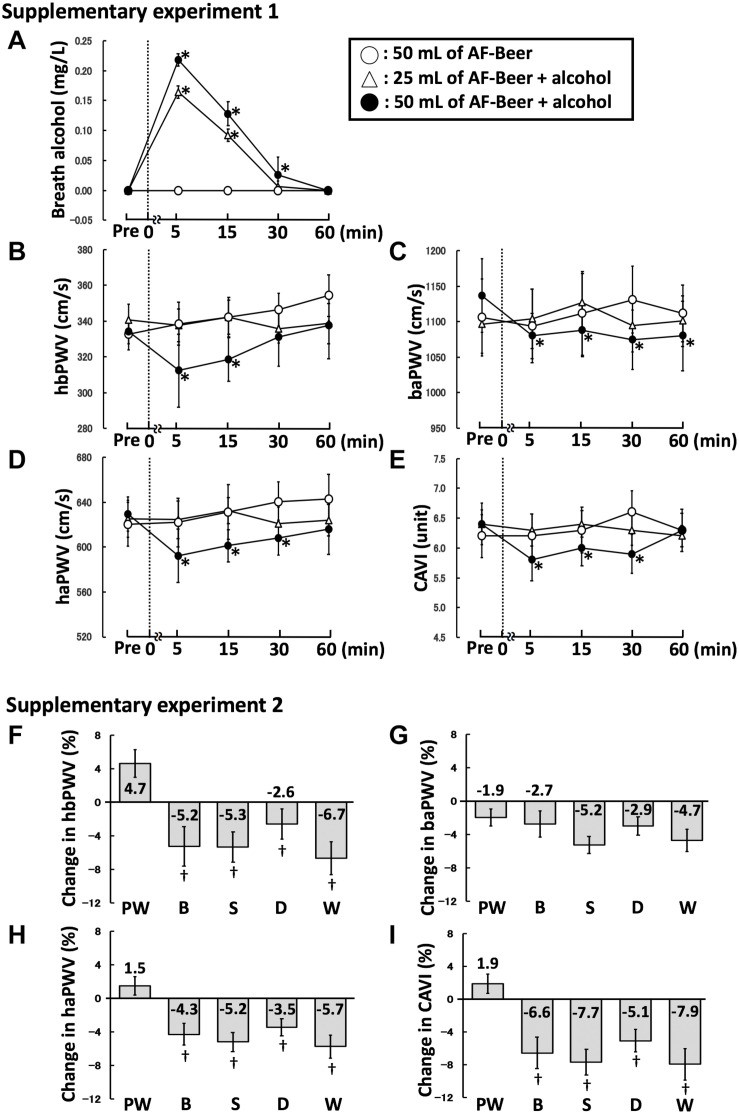
Supplementary experimental findings. Changes in breath alcohol levels (A), hbPWV (B), baPWV (C), haPWV (D), and CAVI (E) in Supplementary Experiment 1. Comparisons of the changes in hbPWV (F), baPWV (G), haPWV (H), and CAVI (I) in Supplementary Experiment 2. Broken lines, time points of beverage ingestion; Pre, baseline, AF-Beer, alcohol-free beer; AF-Beer + alcohol, alcohol mixed with alcohol-free beer as positive control; PW, pure water; B, beer; S, sake; D, Japanese distilled spirits; W, whisky; hbPWV, heart-brachial pulse wave velocity; baPWV, brachial-ankle pulse wave velocity; haPWV, heart-ankle pulse wave velocity; CAVI, cardio-ankle vascular index; *p < 0.05 vs. each pre; †p < 0.05 vs. PW. Data are expressed as mean ± SE.